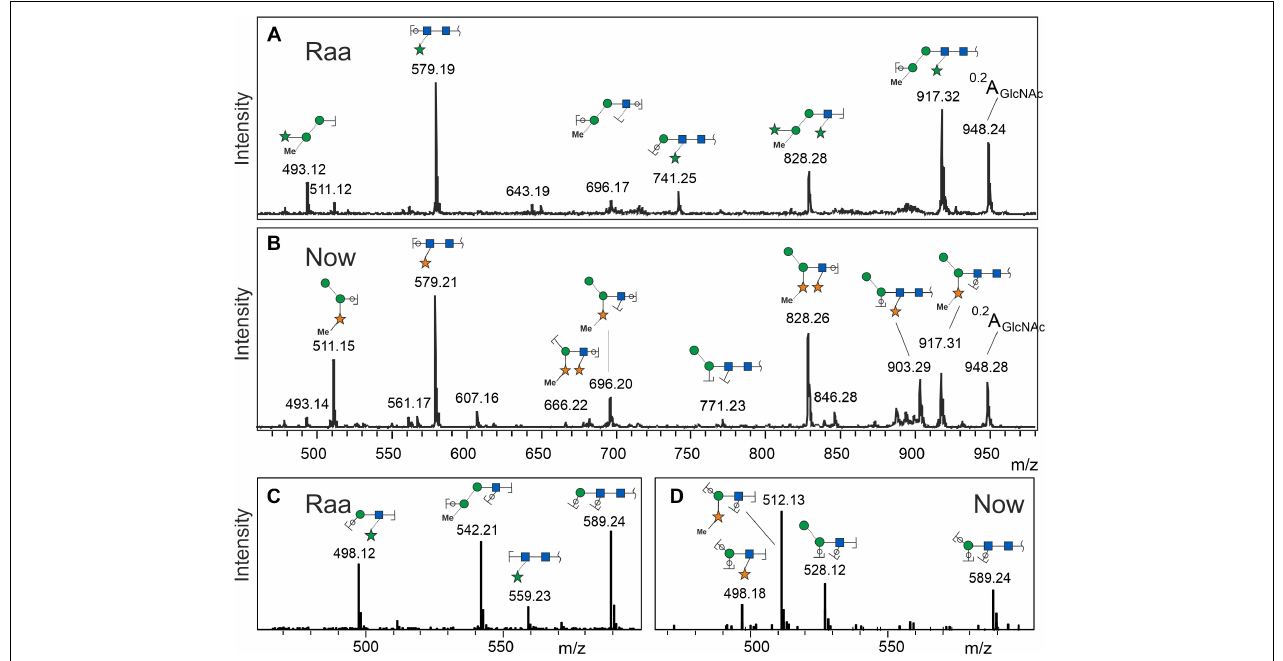
FIGURE 2 | Fragment spectra of the major peak (os2221) by laser-induced dissociation in MALDI-TOF MS (A,B) and collision-induced dissociation in ESI-MS (C,D) . Singly charged Na + or doubly charged, respectively.